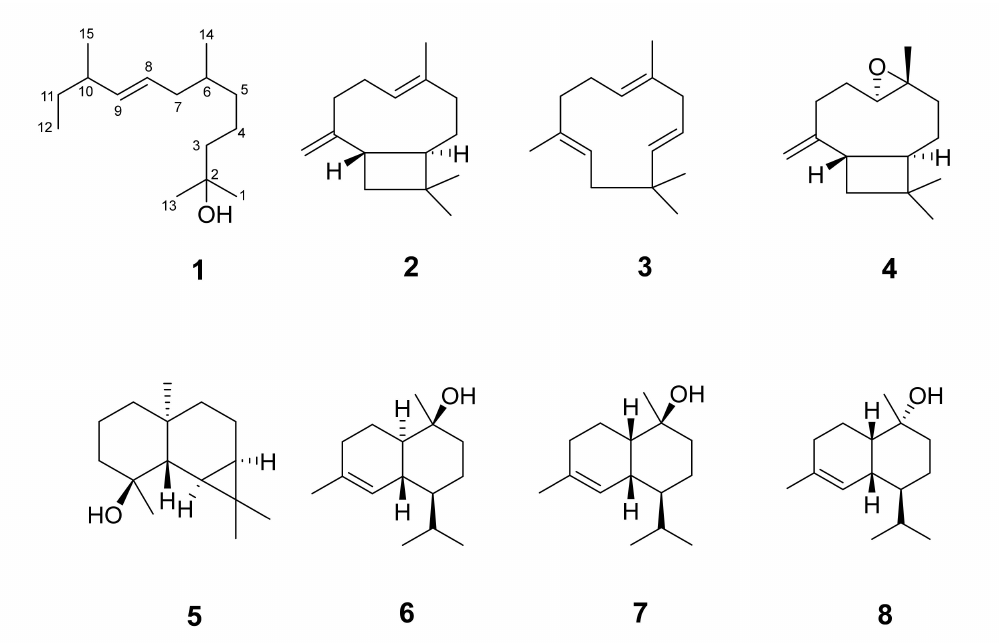
Figure 1. Chemical structures of the isolated